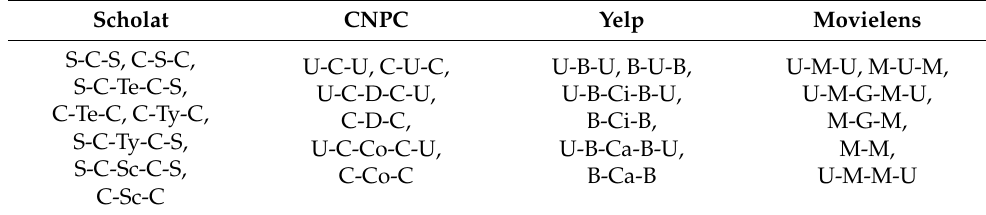
Table 3. Meta-paths of the four